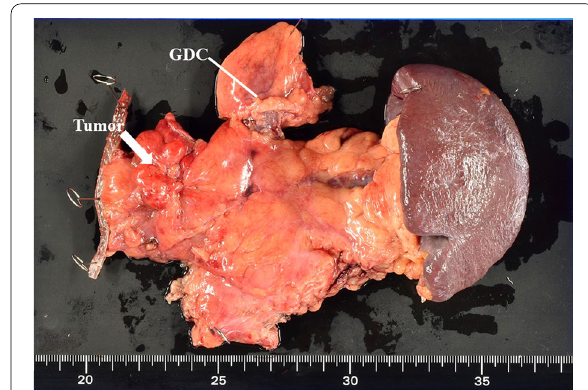
Fig. 4 Macroscopic findings of resected specimens. The tumor was located at the pancreas body and distortion of the pancreas capsule was also observed (white arrow). The GDC was resected en bloc